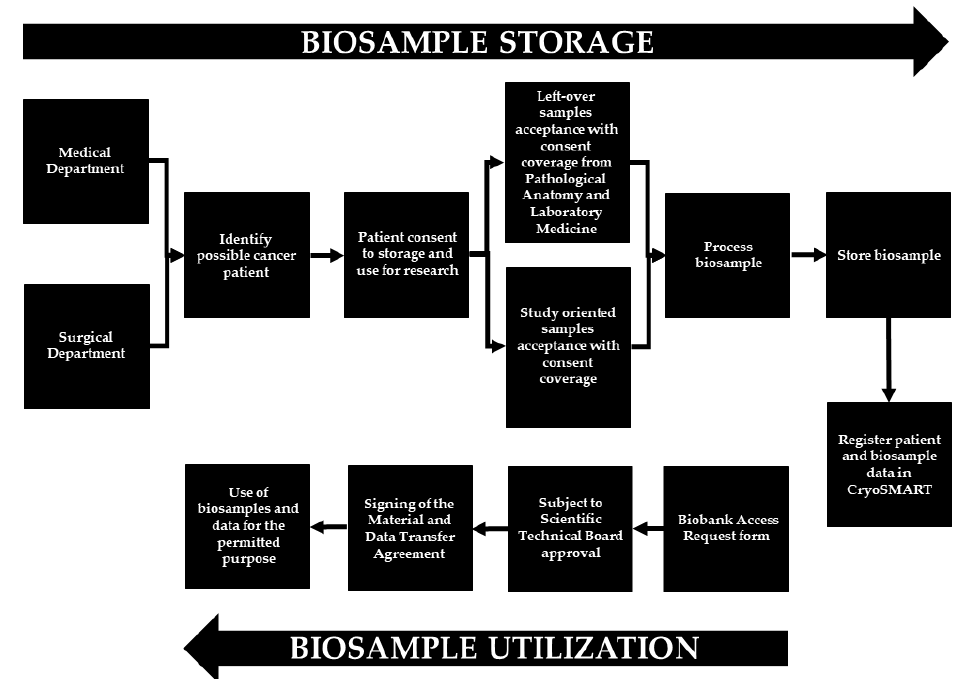
Figure 1. Bari Biobank biosample workflow. The arrow to the right of the figure shows the processes progression designated for the biosample storage. The arrow to the left of the figure shows show those for the biosample utilization.